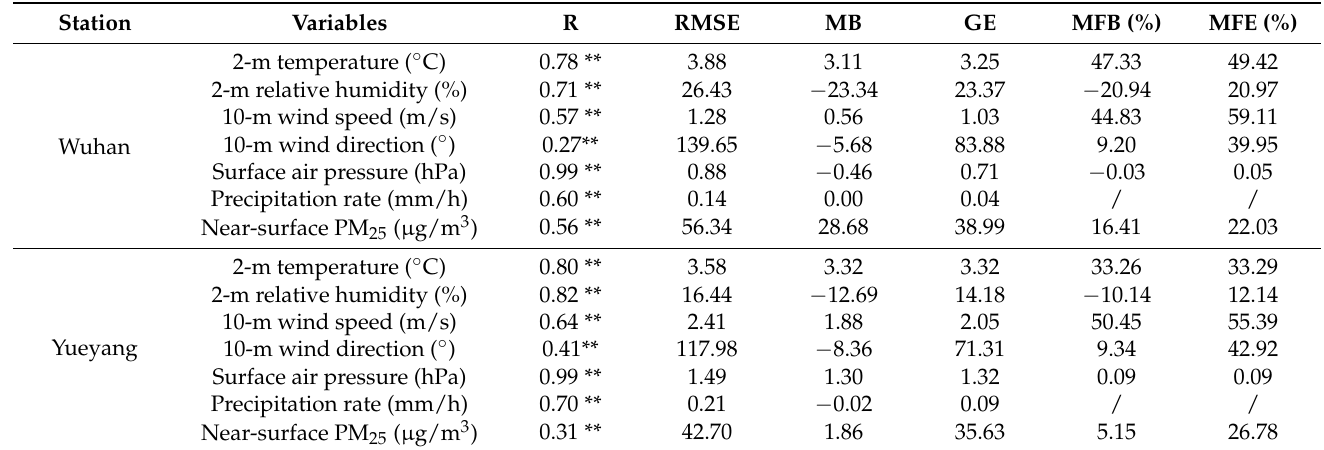
Note: ** indicates that the values have passed the significance test at the 0.01 significance